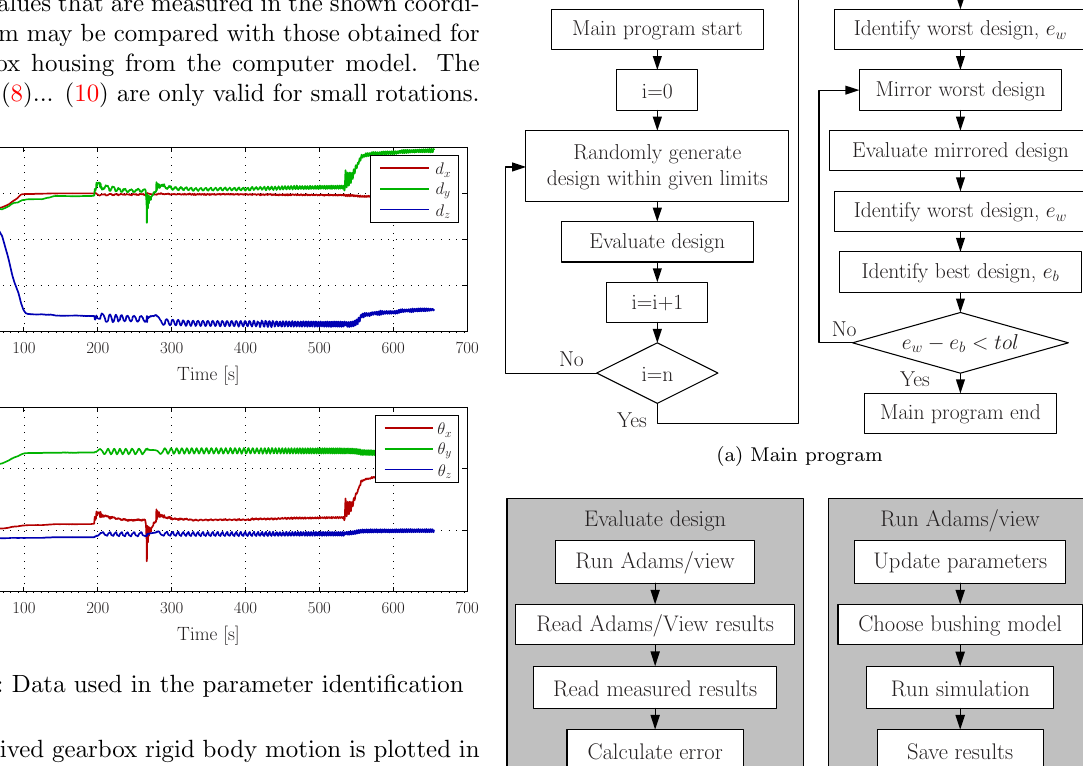
Figure 8: Flow charts of the parameter identification 1965). The population size used here is, in general, two times the number of model parameters. These relatively small populations has yielded both